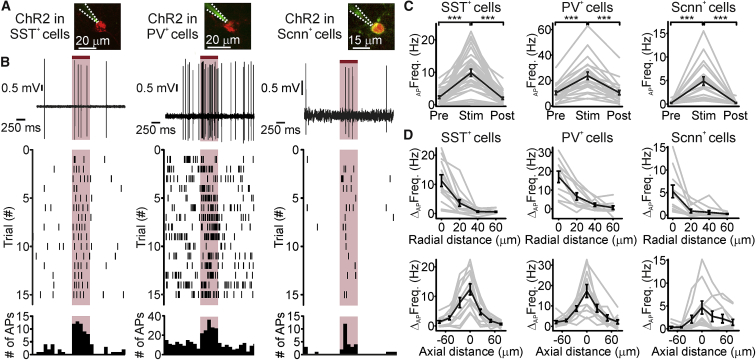
Two-Photon Holographic Stimulation across Cell Types and Layers In Vivo(A) Two-photon image of one layer 2/3 SST+ interneuron (left) and one layer 2/3 PV+ interneuron (middle) expressing ChR2-mCherry (red). One layer 4 Scnn+ neuron expressing ChR2-eYFP (green), together with tdTomato (red), is shown on the right. Neurons were recorded in the juxtasomal configuration with a glass pipette (dotted white line) filled with Alexa Fluor 488 (green) in vivo.(B) Top: electrophysiological traces recorded Pre, during (Stim), and Post holographic stimulation (red bar) for one SST+ cell (left), one PV+ cell (middle), and one Scnn+ cell (right). λexc = 920 nm. Laser power: 30 mW for SST+ and PV+ cells and 50 mW for Scnn+ neurons. Middle: raster plot showing cell response over consecutive trials for the same neurons displayed in the top panel. Bottom: AP distribution for the trials shown in the middle panel (time bin: 100 ms) for all cell types (SST+, left; PV+, middle; Scnn+, right).(C) Average firing frequency Pre, during (Stim), and Post holographic stimulation of ChR2-expressing layer 2/3 SST+ neurons (left), layer 2/3 PV+ neurons (middle), and layer 4 Scnn+ neurons (right). SST+ cells: p = 1.3E−9, Friedmann test with Dunn’s correction, N = 31 cells from 7 mice. PV+ cells: p = 1.2E−7, ANOVA test with Bonferroni’s correction, N = 22 cells from 7 mice. Scnn+ cells p = 5.2E−7, Friedmann test with Dunn’s correction, N = 19 cells from 8 mice. Laser power: 30 mW for SST+ and PV+ cells and 50 mW for Scnn+ cells.(D) Firing frequency increase versus displacement in the radial (top) and axial (bottom) directions during holographic illumination for layer 2/3 SST+ neurons (left), layer 2/3 PV+ neurons (middle), and layer 4 Scnn+ neurons (right). SST+ cells: top, N = 13 cells from 3 mice; bottom, N = 12 cells from 3 mice. PV+ cells: top, N = 10 cells from 4 mice; bottom, N = 11 cells from 4 mice. Scnn+ cells: top and bottom, N = 11 cells from 5 mice.In this figure, the black line represents the average and SEM, individual experiments are depicted in gray. See also Figure S5 and Tables S1–S3.